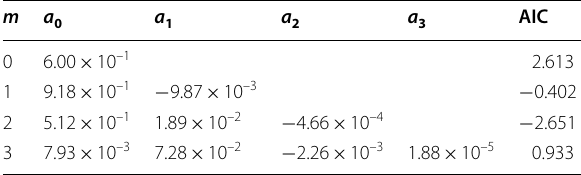
Table 2 Polynomial fitting to the stress ratio